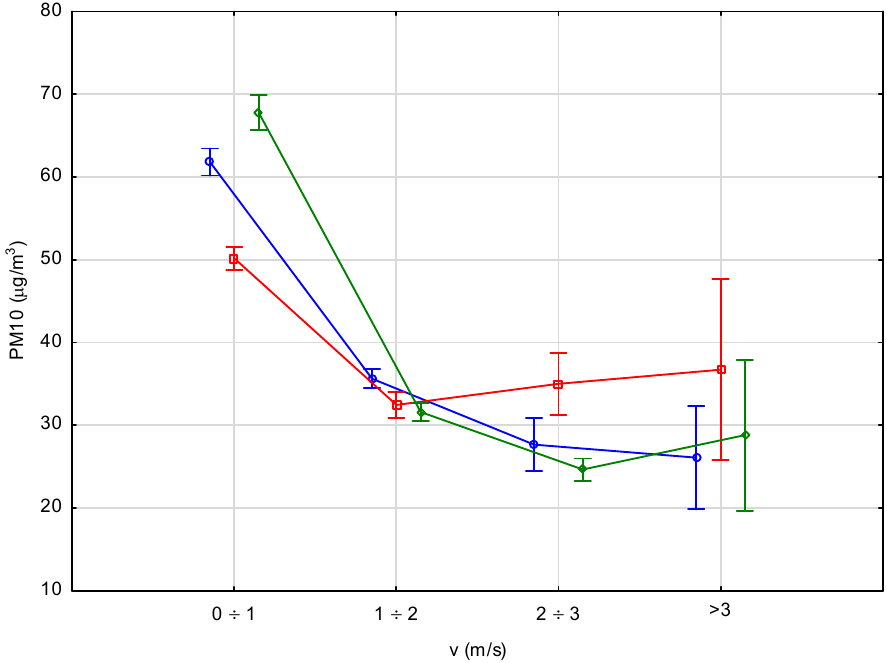
Figure 7. Relation between SO 2 concentration and wind speed for the analyzed heating seasons.